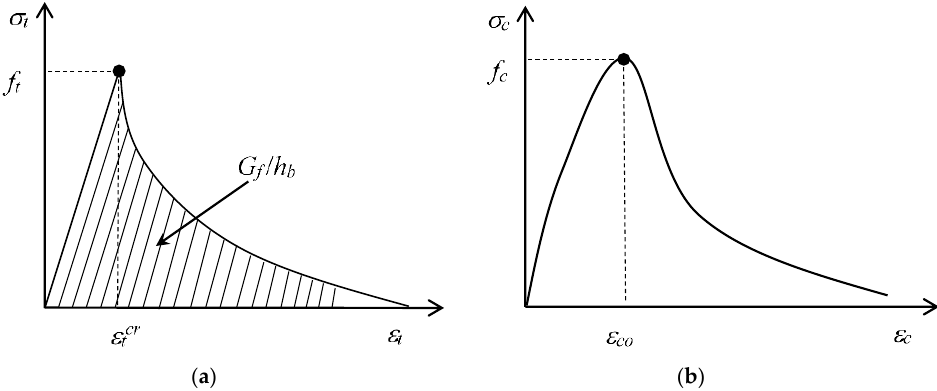
Figure 1. Stress–strain relationship of concrete: ( a ) tension model; ( b ) compression model.